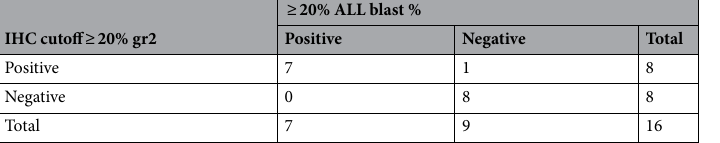
IHC cutoff ≥ 20% gr2